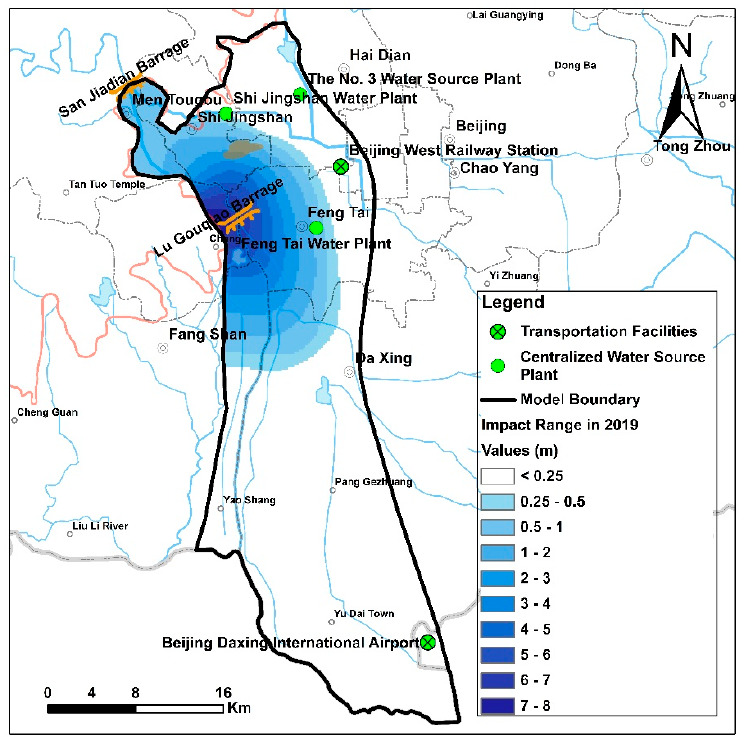
Figure 7. Uplift variation map of the groundwater level in the ecological water supplement region.